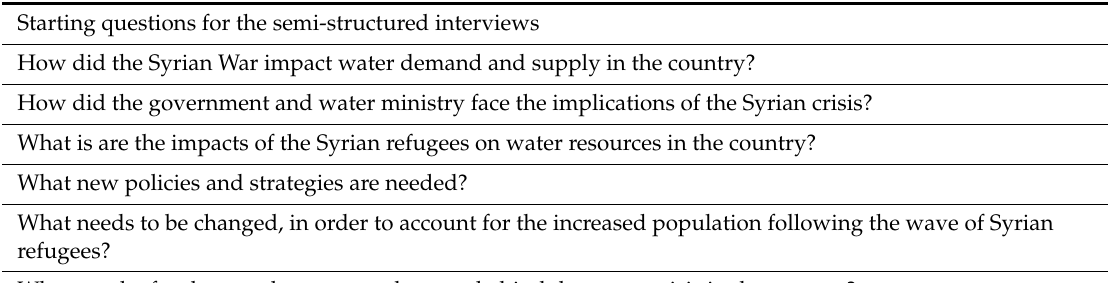
Table 1. Starting questions for the semi-structured